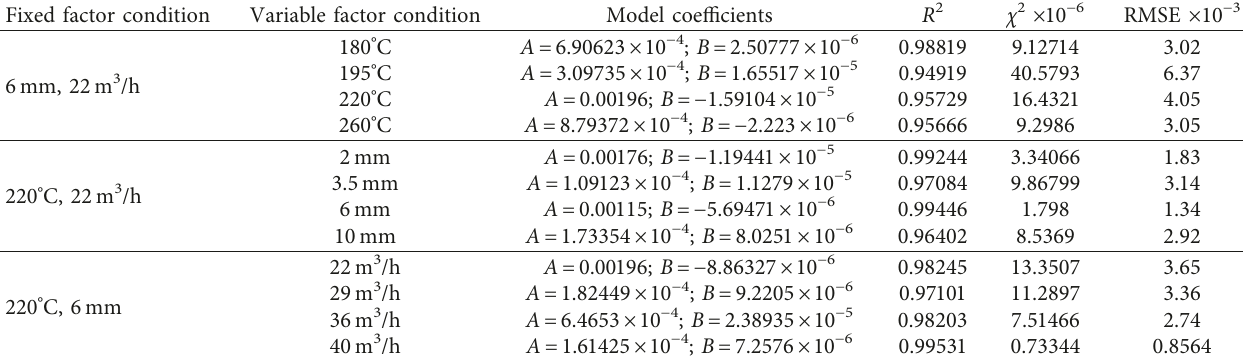
Table 2: Fitting results of condensation stage of sludge superheated steam drying under different drying conditions. Fixed factor condition